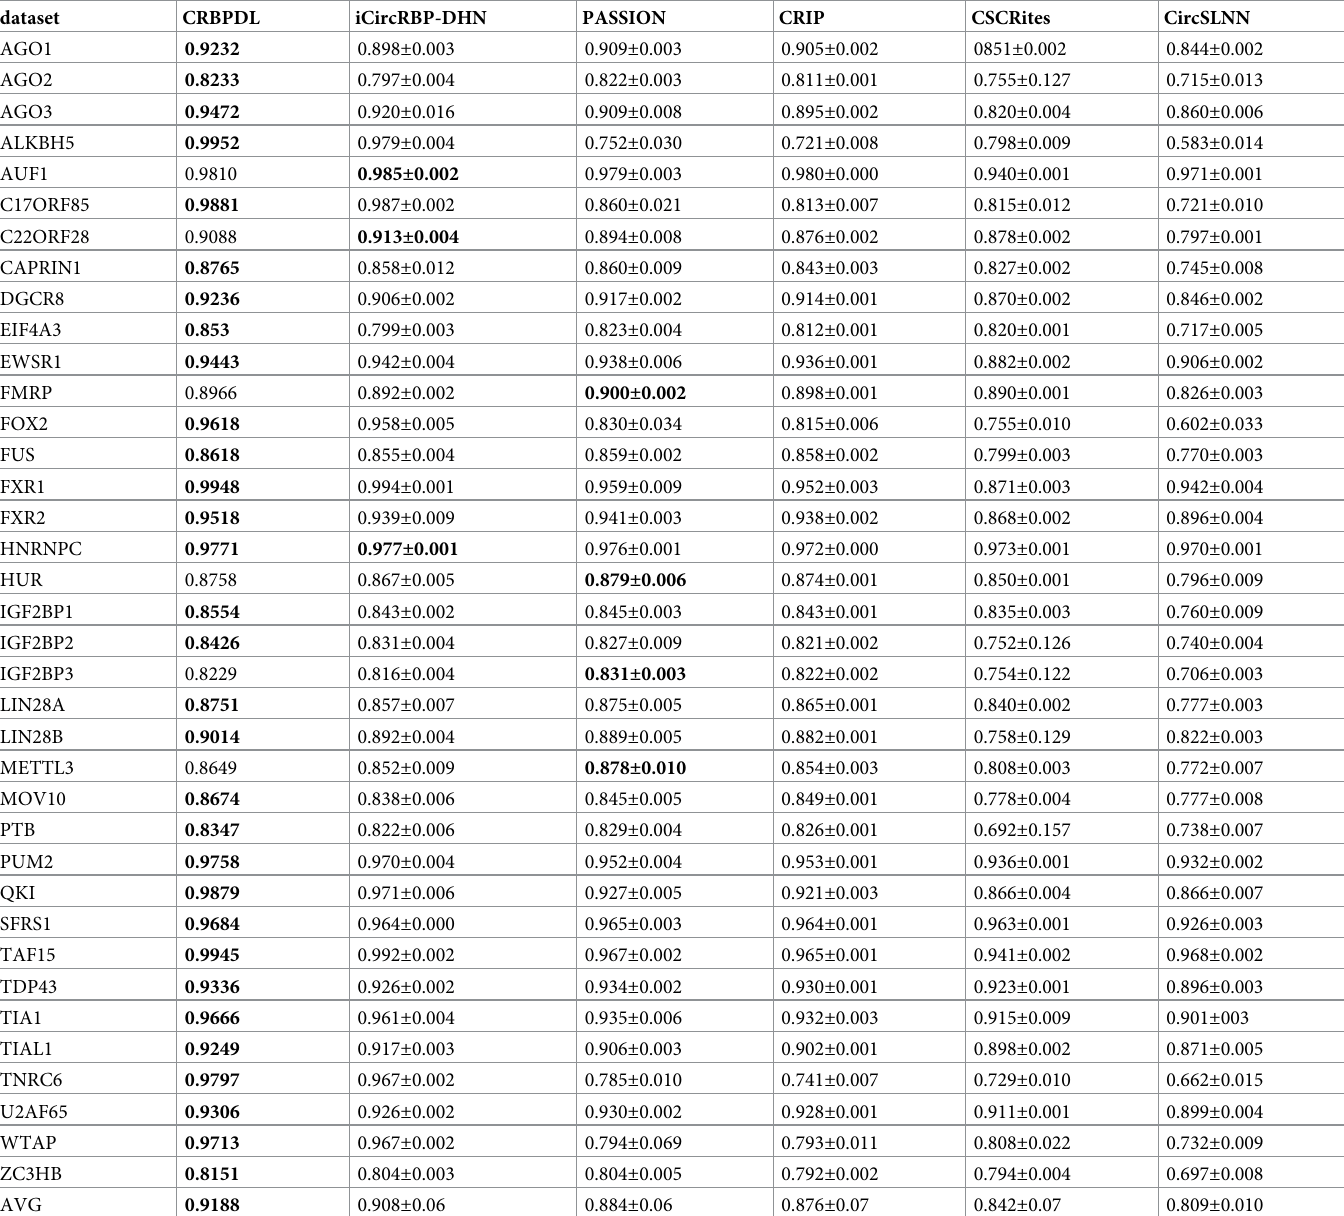
Table 1. Comparison of prediction performance under different classification models on 37 circRNA